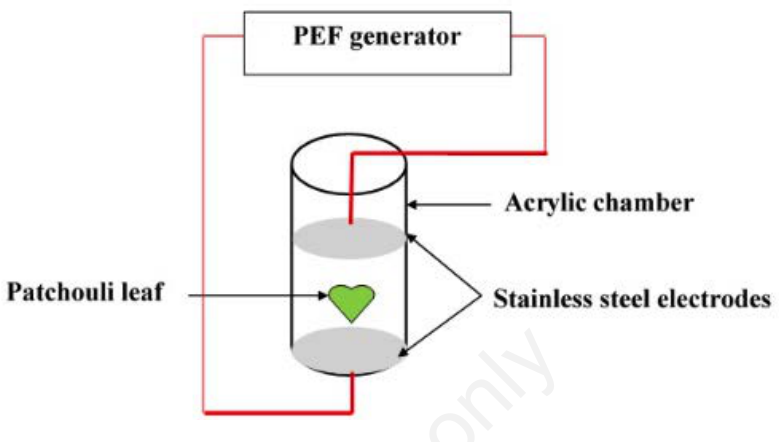
Figure 1. The electric field treatment of patchouli leaves with the PEF generator.